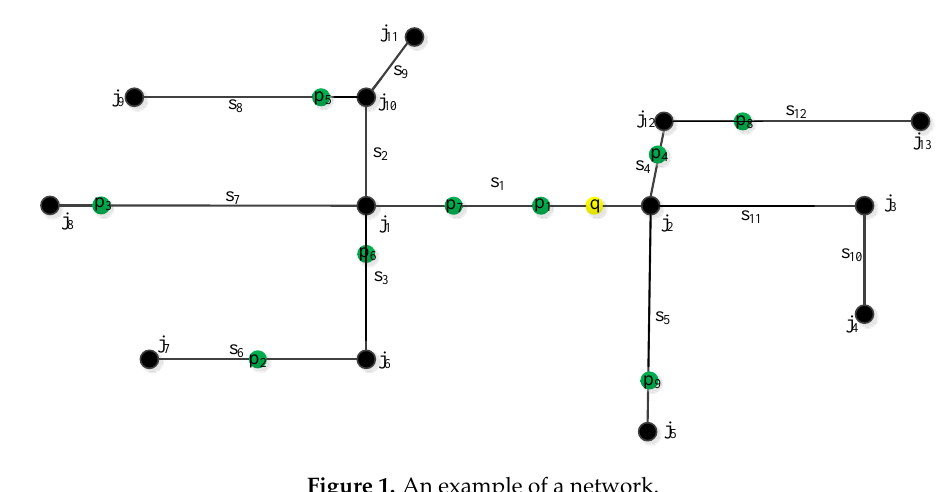
Figure 1. An example of a